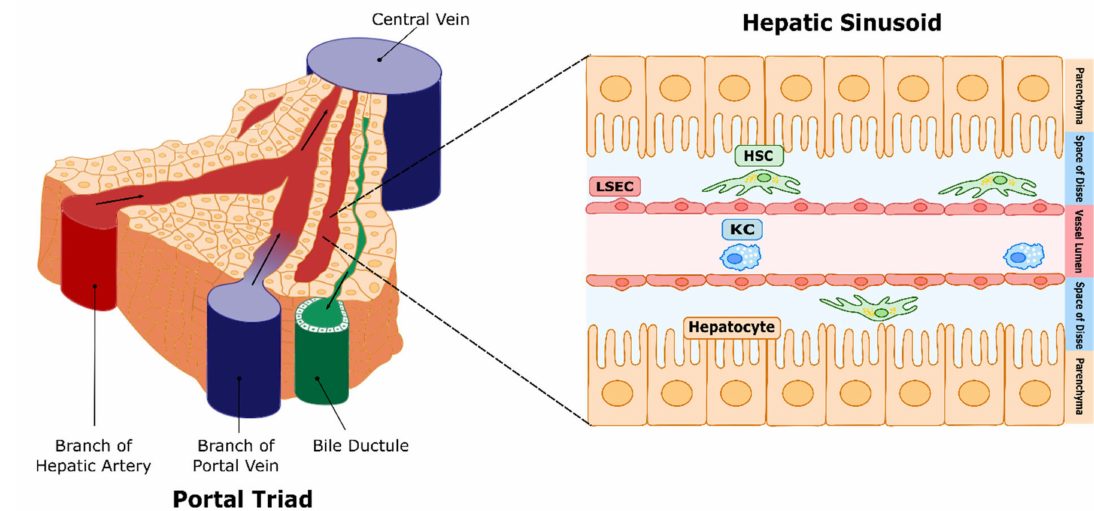
Figure 1. Hepatic circulation and microcirculation. Representation of the liver circulation, with the portal triad, which includes the hepatic artery, which supplies oxygenated blood; the portal vein, carrying blood rich in nutrients from the small intestine; and the bile duct, which collects bile products secreted by hepatocytes. Blood then mixes along the sinusoids, which are the liver microvessels (right panel), and drains into the central vein, which leads to the vena cava. Liver sinusoidal endothelial cells (LSECs) constitute the walls of the microvessel. Hepatic stellate cells (HSCs) reside in the space defined between LSECs and hepatocytes (space of Disse), and act as the sinusoidal pericytes, while Kupffer cells (KCs) (resident macrophages) are located in the sinusoidal